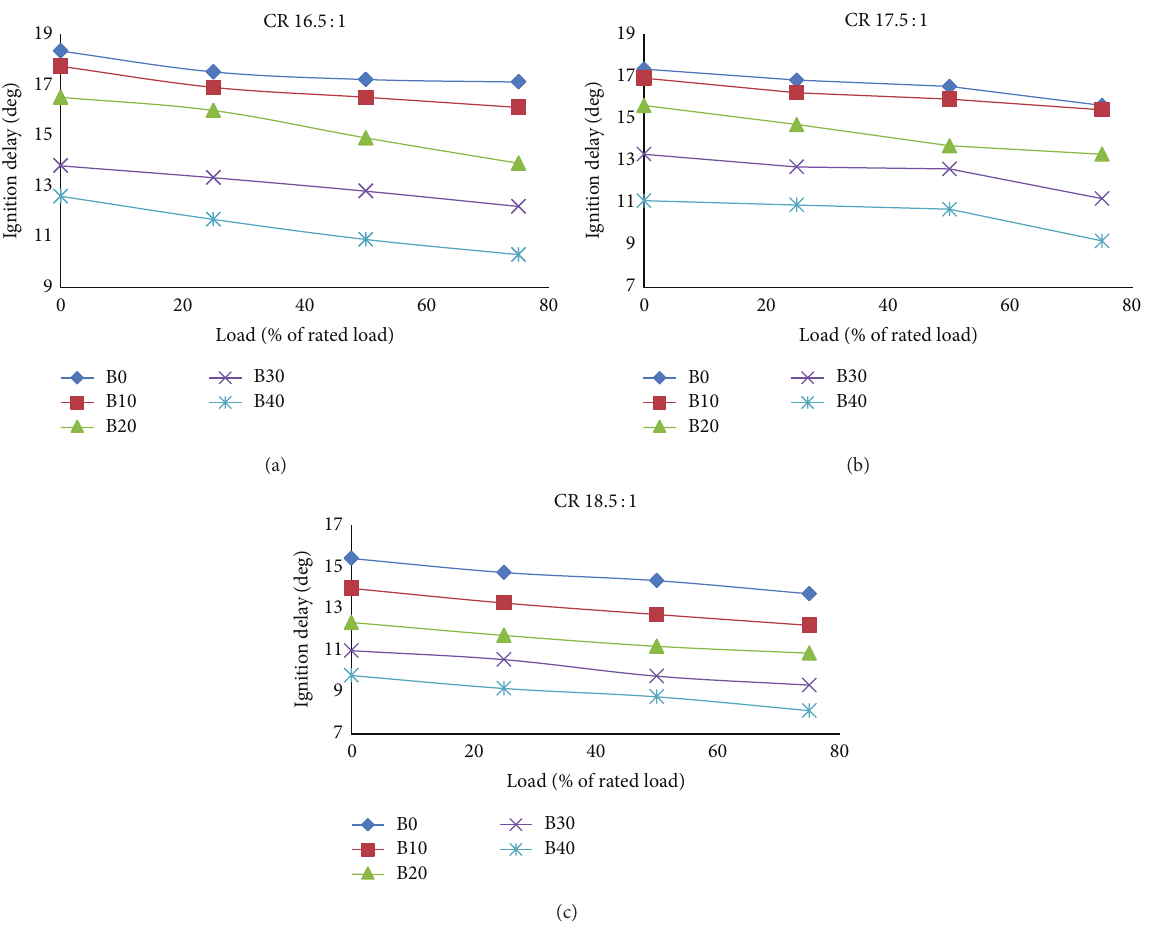
Figure 7: Effect of engine load on the ignition delay period for diesel and ethyl ester blends at different compression ratios.